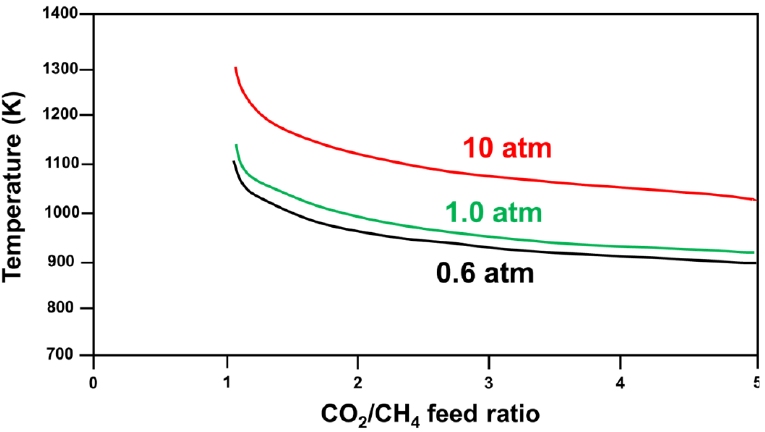
Figure 8. Thermodynamic analysis of total pressures, temperatures, and feed ratios for carbon formation. Reprinted with permission from Ref. [6]. Copyright 2016 Royal Society of Chemistry.